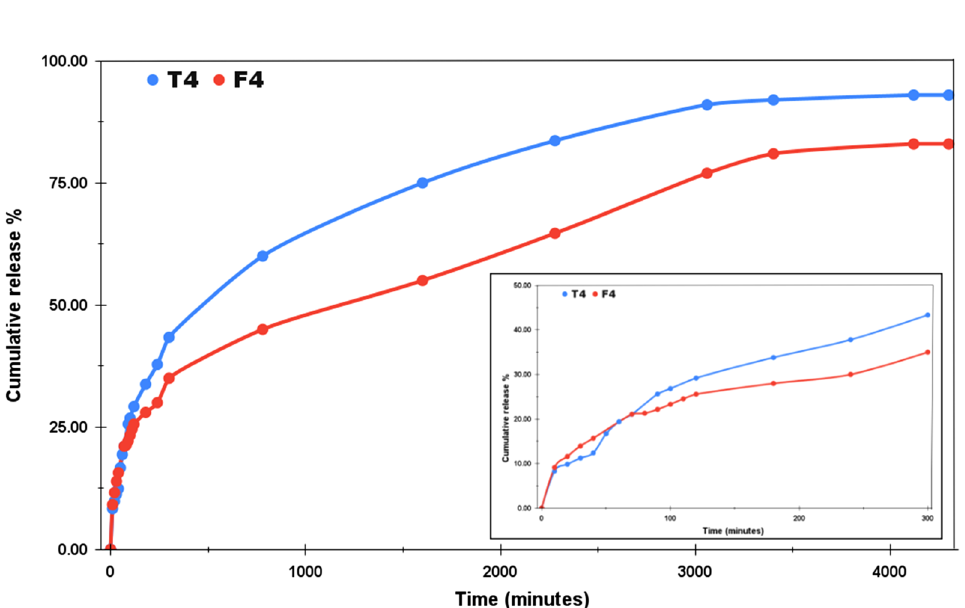
Figure 6. The Imatinib release profiles of Drug/TiO 2 NPs and Drug/Fe@TiO 2 NPs at pH 4.4.